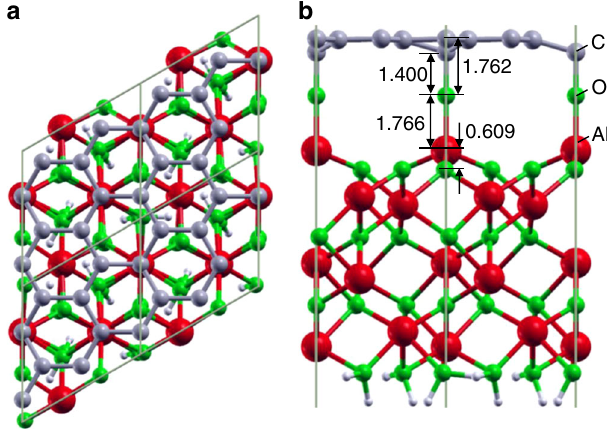
Fig. 2 Calculated interface structure of Gr/ α -Al 2 O 3 . a Top view. b Side view. The unit of length is Å. Red: Al atom. Green: O atom. Gray: C atom